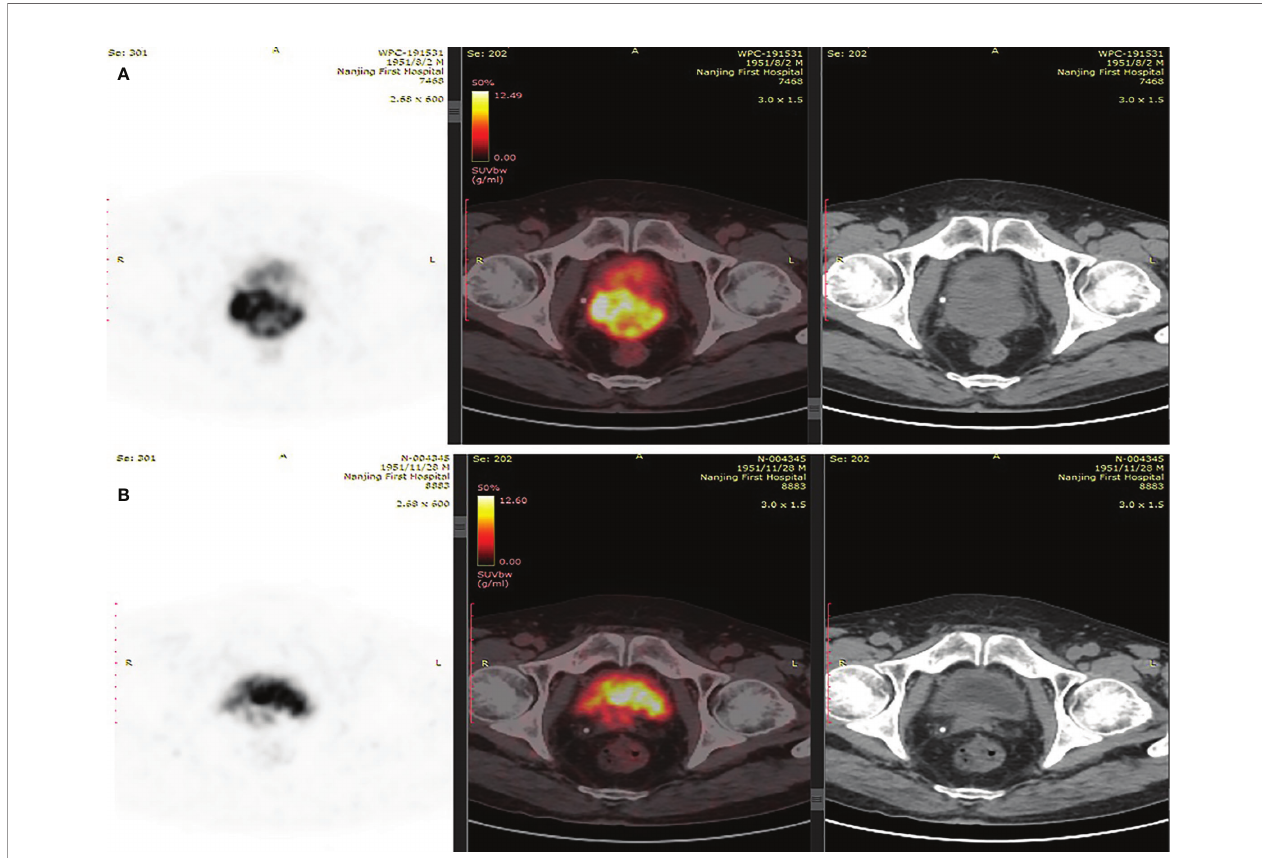
FIGURE 2 | (A) PSMA-PET/CT scans suggested of uneven increase in PSMA expression of prostate. (B) PSMA-PET/CT scans showed shrunken lesions after platinum-based neoadjuvant